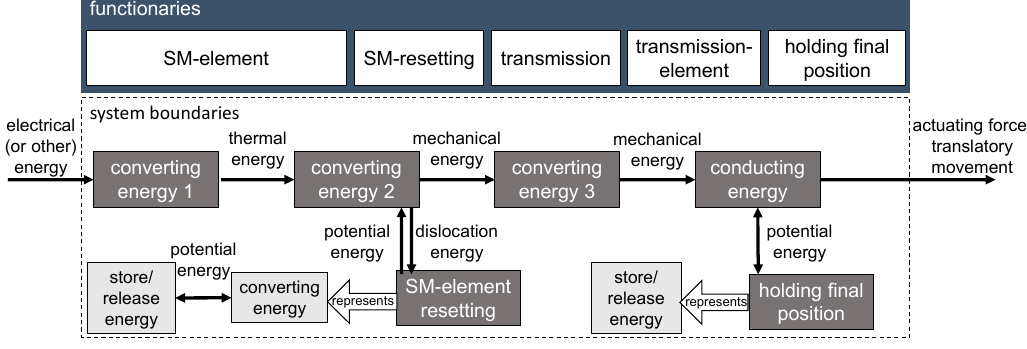
Figure 1. Function structure for the actuator to be developed.